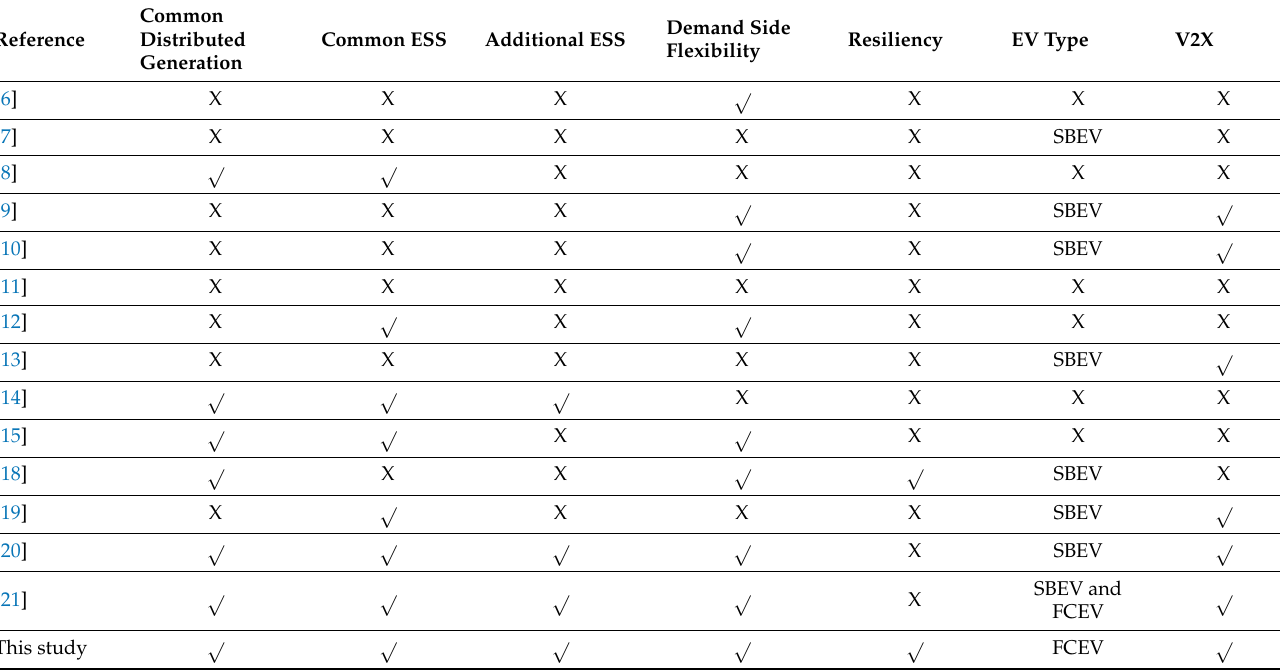
Table 1. The taxonomy of the relevant